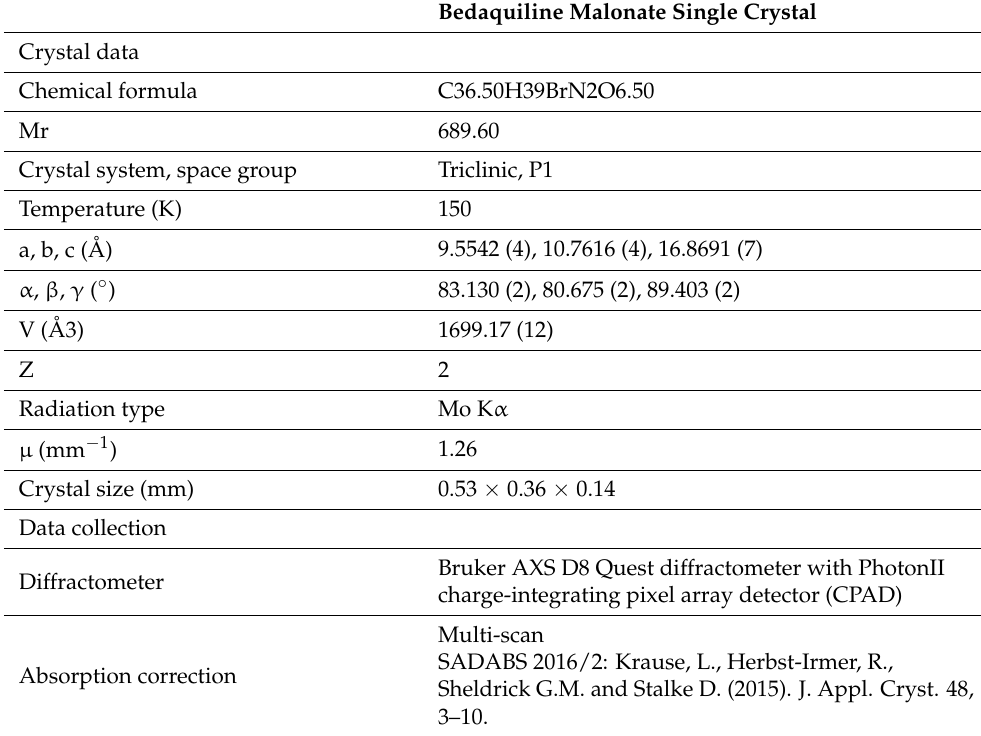
Table A3. Experimental details for bedaquiline malonate single